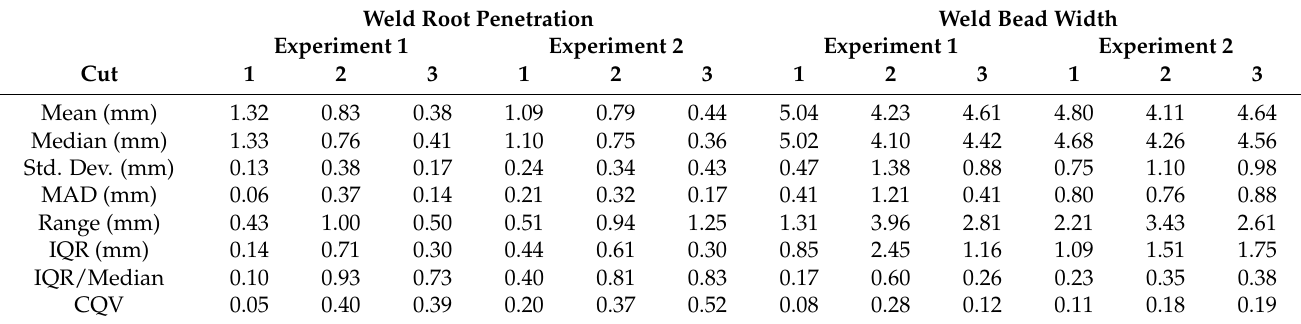
Figure 6. Correlation matrix and plot between the different cuts for the same specimen within the experiment 1. Table 4. Summary of the results of the two measured features for the 9 specimens of the experiment 1 and the 9 specimens of experiment